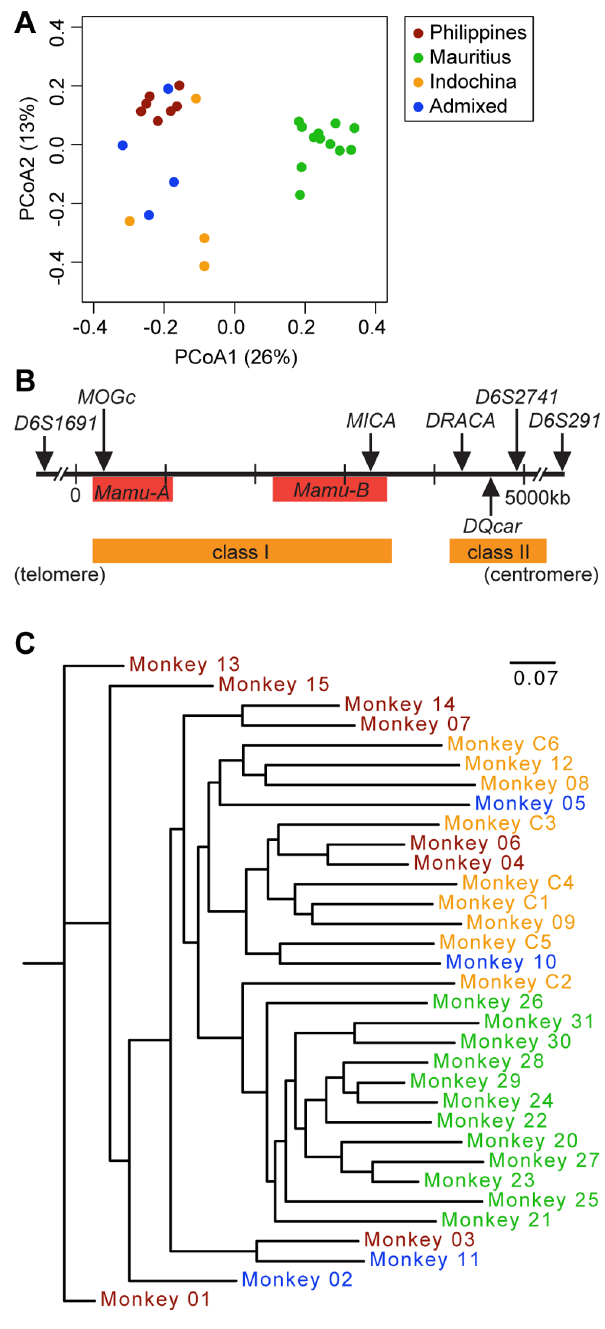
Figure 5. Analysis of genetic variability of cynomolgus macaques in studies 1–4. ( A ) Principal coordinates analysis (PCoA) based on Lynch pairwise distance calculated from 24 STR data derived from archived peripheral blood lymphocytes from each cynomolgus macaque in studies 1, 2, and 3. Each individual dot represents an individual macaque, color-coded by geographic origin (boxed inset), with percent variance shown on each axis. ( B ) Localization of seven microsatellite markers tested within the MHC region (adapted from rhesus macaque MHC map) [26]. ( C ) Phylogenetic tree calculated from indicated MHC microsatellite data for all macaques (studies 1–4), using the Lynch pairwise distance measure. Individual macaques are color- coded as indicated in the boxed inset in ( A